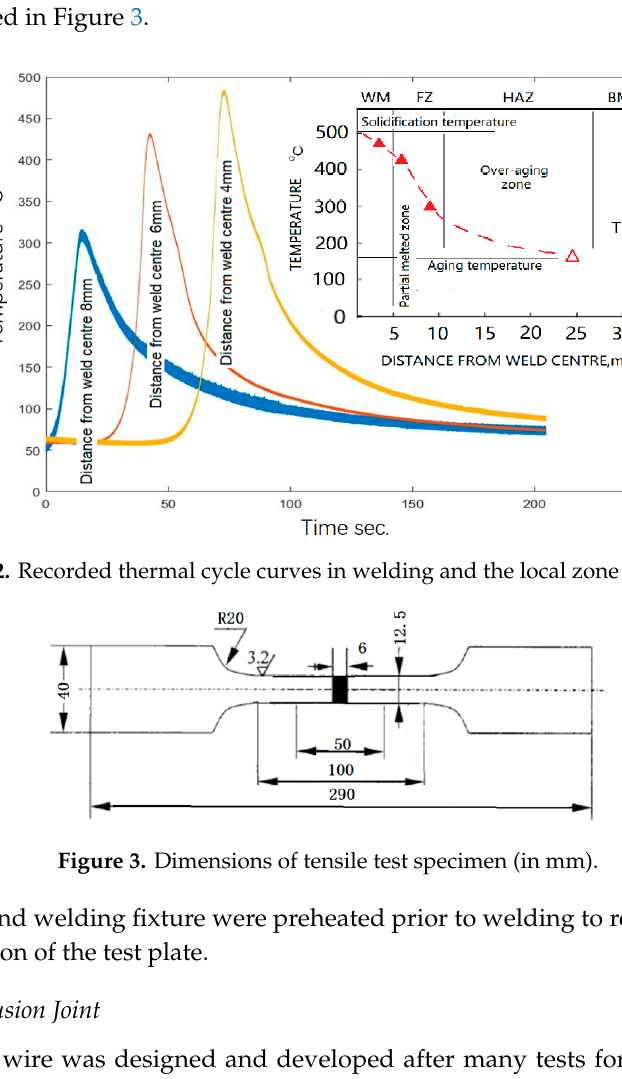
Figure 3. Dimensions of tensile test specimen (in mm).